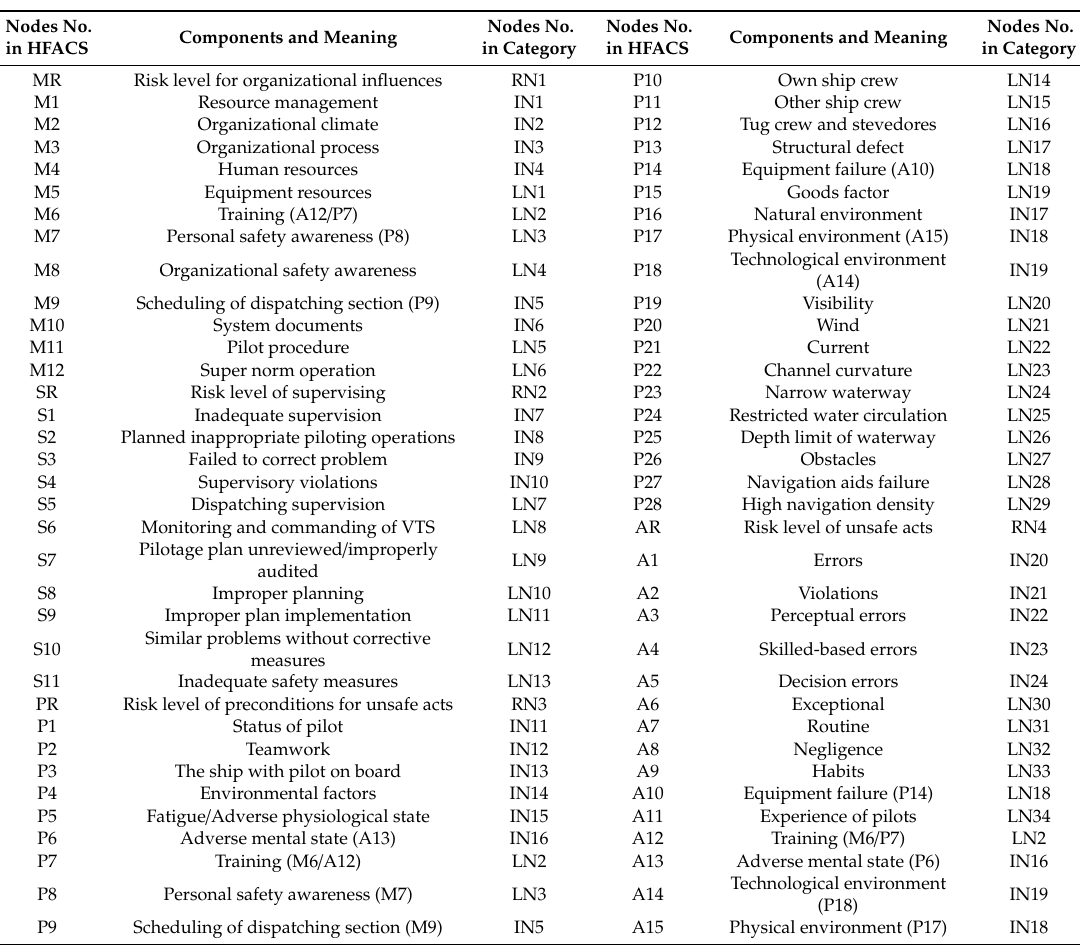
Nodes No. in Category